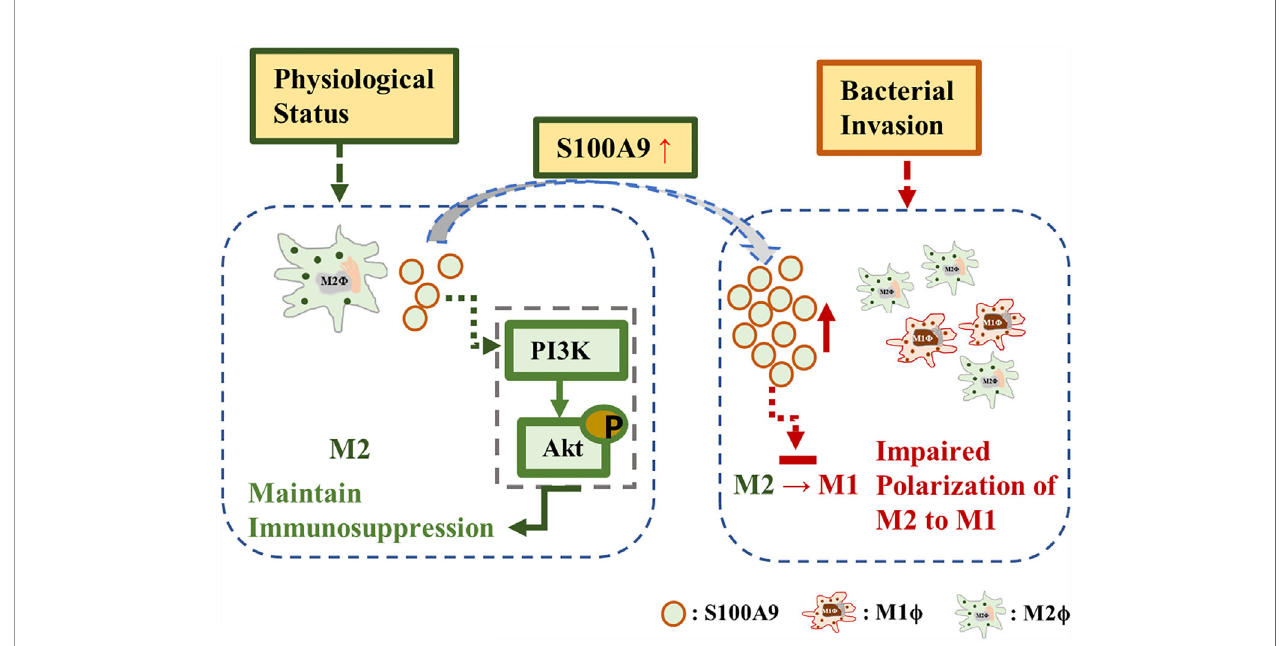
FIGURE 6 | S100A9 mechanism. S100A9 contributed to maintain the M2 polarization of testicular macrophages through the activation of PI3K/Akt pathway under physiological condition. During in fl ammation, the elevated S100A9 weakened the polarization of testicular macrophages from M2 to